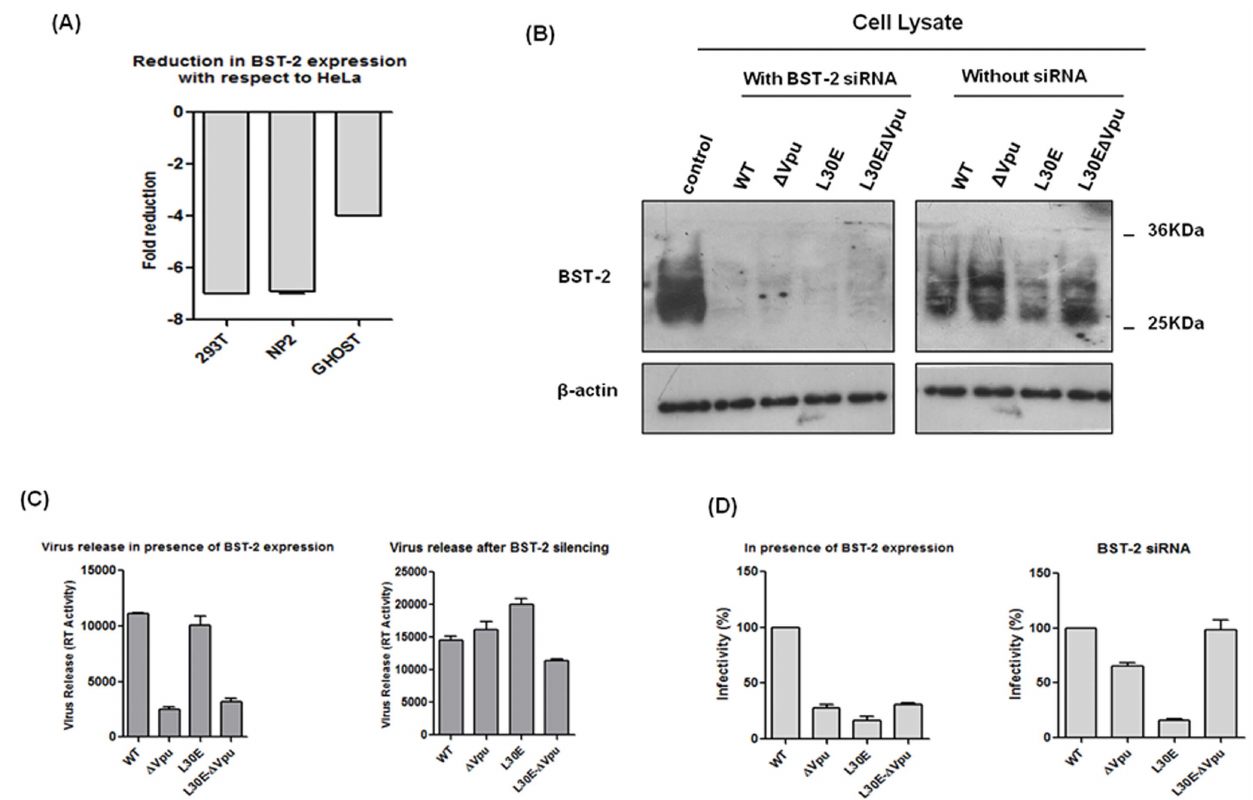
Figure 8. Knockdown of endogenous BST-2 in HeLa cells increases production of infectious HIV-1 particles. (A) Relative Real-time analysis of endogenous expression of BST-2 was done in three cell-types (293T, NP2, GHOST) using HeLa as a control. Plot represents fold reduction in the mRNA expression of BST-2 in different cell-types with respect to HeLa. (B) Western blotting was used to determine the change in expression of BST-2 in HeLa cells in presence and absence of BST-2 siRNA; Control was lysate of cells transfected with control siRNA and b -actin was used as a loading control. (C) Levels of HIV-1 particles in supernatants obtained from transfected HeLa cells (with and without BST-2 siRNA) were quantified by measuring viral RT activity. (D) Infectivity titre of WT and mutant viruses produced from transfected HeLa cells (with and without BST-2 siRNA) was determined in TZM-bl cells by Luciferase assay.